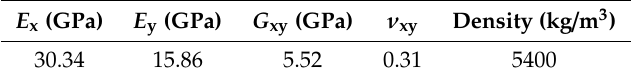
Table 3. Mechanical properties of MFC [33], E x and E y are the elastic modulus in the rod and electrode directions, respectively.